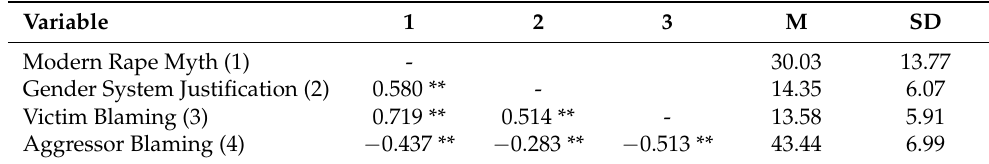
Table 2. Bivariate correlation, mean, and standard deviation.